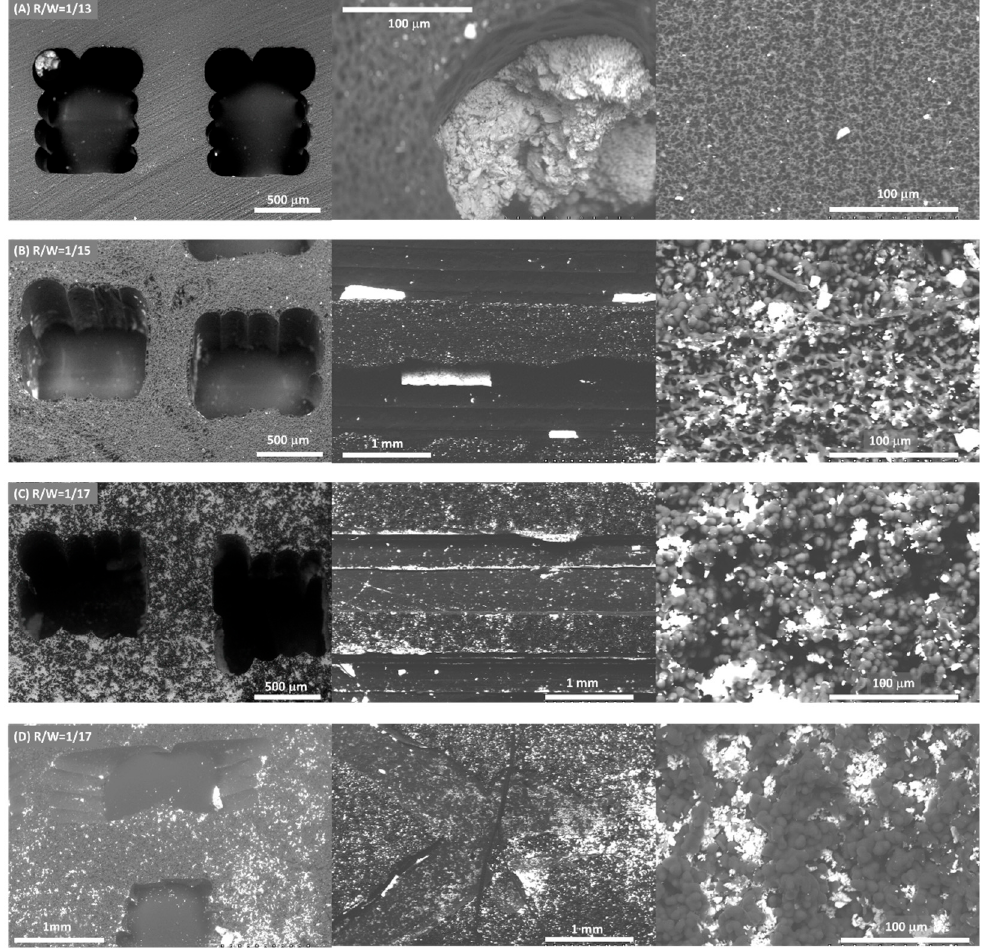
Figure 4. Distribution of Ni/CeO 2 active phase (white) on the surface of carbon (grey) monoliths prepared with different R/W molar ratio for conventional design ( A – C ) and R/W = 17 for tortuous design ( D ). Left : Monolith transversal section, center: Monolith longitudinal section and Right : Inside channel wall.